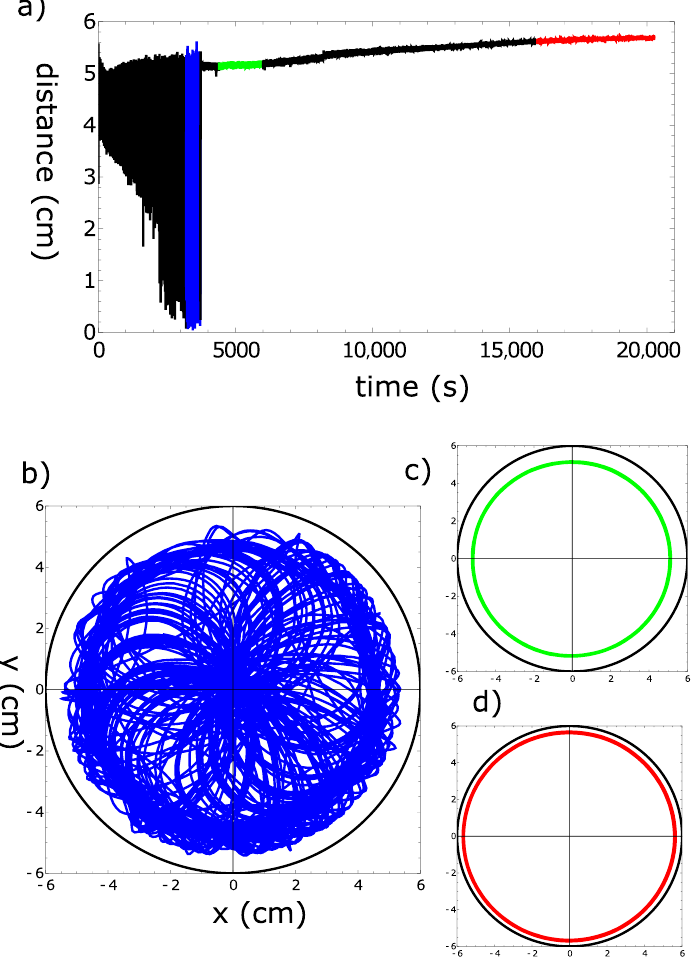
Figure 14. Long-time evolution of a 4 mm pill made of camphene–camphor–polypropylene plastic with a 45% camphene, 45% camphor, and 10% polypropylene weight ratio. ( a ) The distance between the pill center and the dish center as a function of time. The color fragments correspond to the trajectories shown in the figures located below. ( b – d ) Trajectories observed in time intervals [ 3200 s, 3700 s], [ 4400 s, 6000 s], and [ 16,000 s, 20,200 s], respectively. The black circles in ( b – d ) indicate the location of the dish